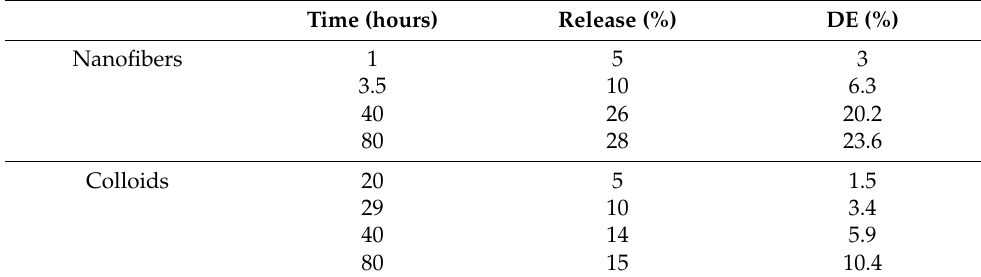
Table 1. DE values estimated both at fixed times (40 and 80 h) and drug release percentages (5 and 10%), to which different release mechanisms are associated. Time (hours) Release (%) DE